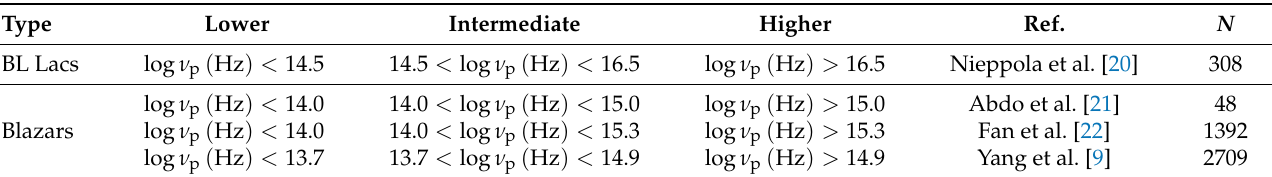
Table 1. The boundaries of blazar